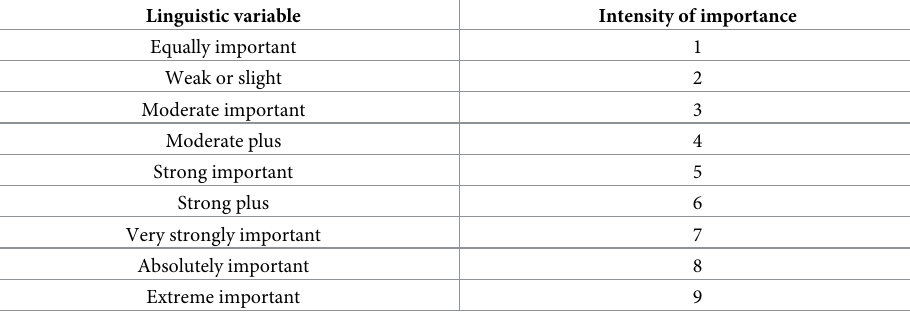
Table 2. Relative importance of linguistic variables to the 1–9